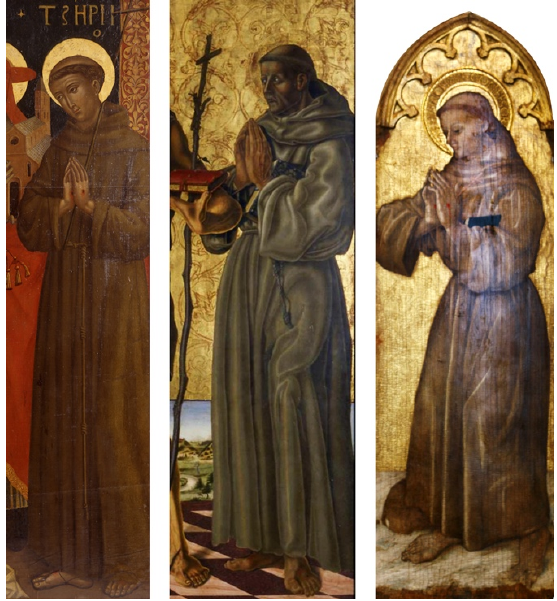
Figure 10. Angelos Bitzamanos. Saint Francis (detail from the Scottivoli altarpiece), 1508. Vatican, Apostolic Palace ( left ) © Musei Vaticani. Reproduced with permission; Nicola di Maestro Antonio d’Ancona. Saint Francis, 1472. Pittsburgh, Carnegie Museum of Art ( middle ) Image in the public domain; Nicola di Maestro Antonio d’Ancona. Saint Francis (detail from the polyptych of Jesi), 1487. Avignon ( right ) Image in the public domain; Figure created by author.